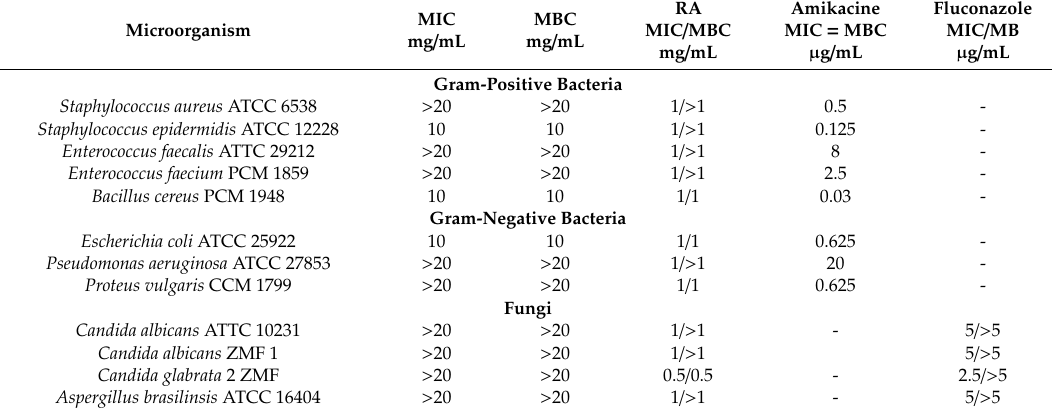
Table 4. Antimicrobial activity of hydromethanolic extract from D. forrestii transformed shoots cultured for 3 weeks in NSB in MS medium with BPA 0.5 mg / L and IAA 0.2 mg / L. Microorganism